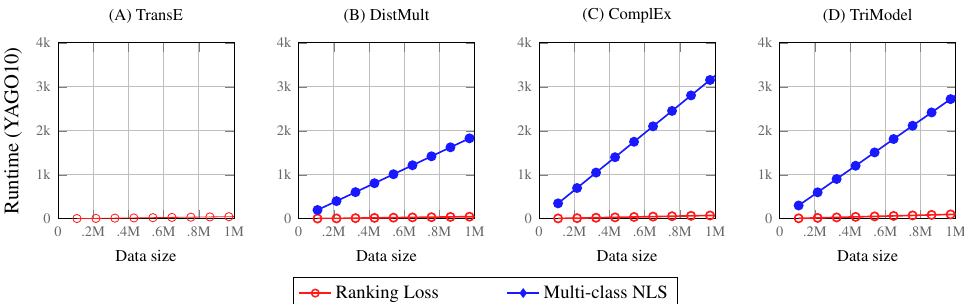
Figure 4. A set of plots that describe the relation between the training runtime (in seconds) and the dataset size for the multi-class and ranking losses for di ff erent models on the YAGO10 dataset. The results reported in this figure are acquired by training KGE models with a small embedding of dimension 10 for 20 iterations. The TransE model’s plot reports only results for ranking loss